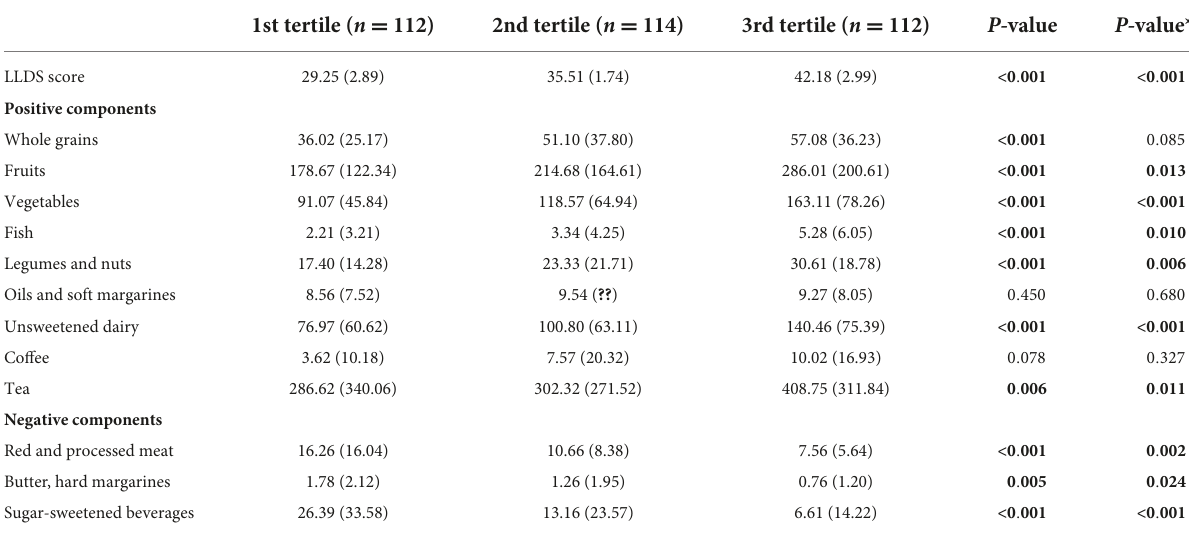
TABLE 4 Consumption rates of 12 Lifelines Diet Score (LLDS) components (grams/1,000